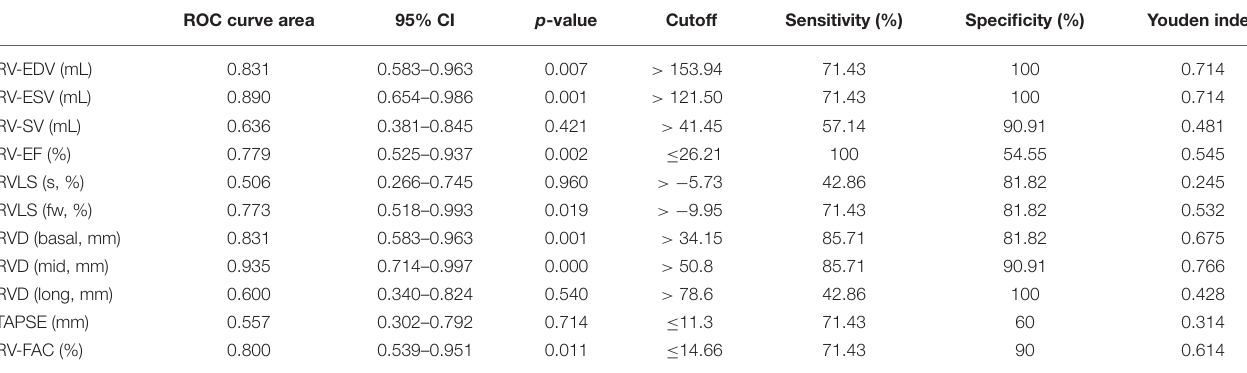
TABLE 6 | High-quality image group of PHTNs ( n = 24) of 4D auto-RVQ areas of receiver operating characteristic (ROC) curves of various right ventricular function parameters. ROC curve area 95% CI p -value Cutoff Sensitivity (%) Specificity (%) Youden